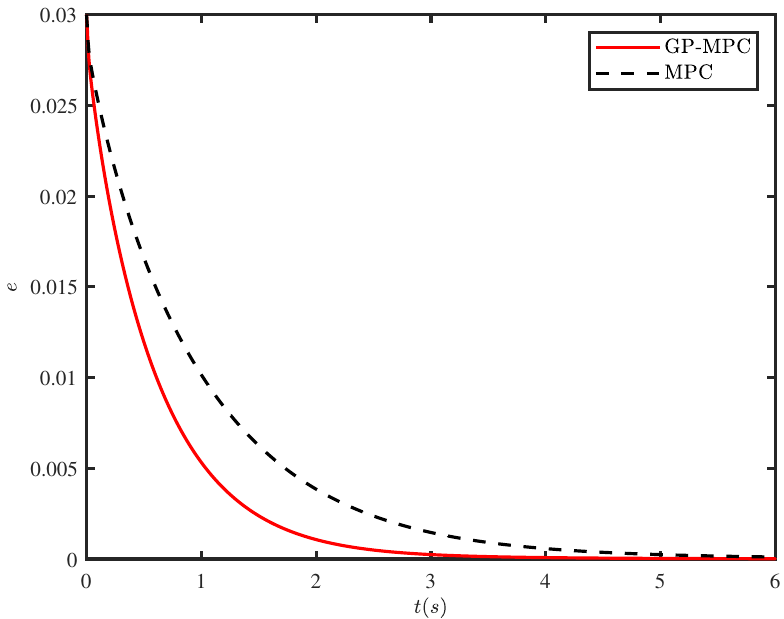
Figure 9. Displacement control error of GP-MPC and